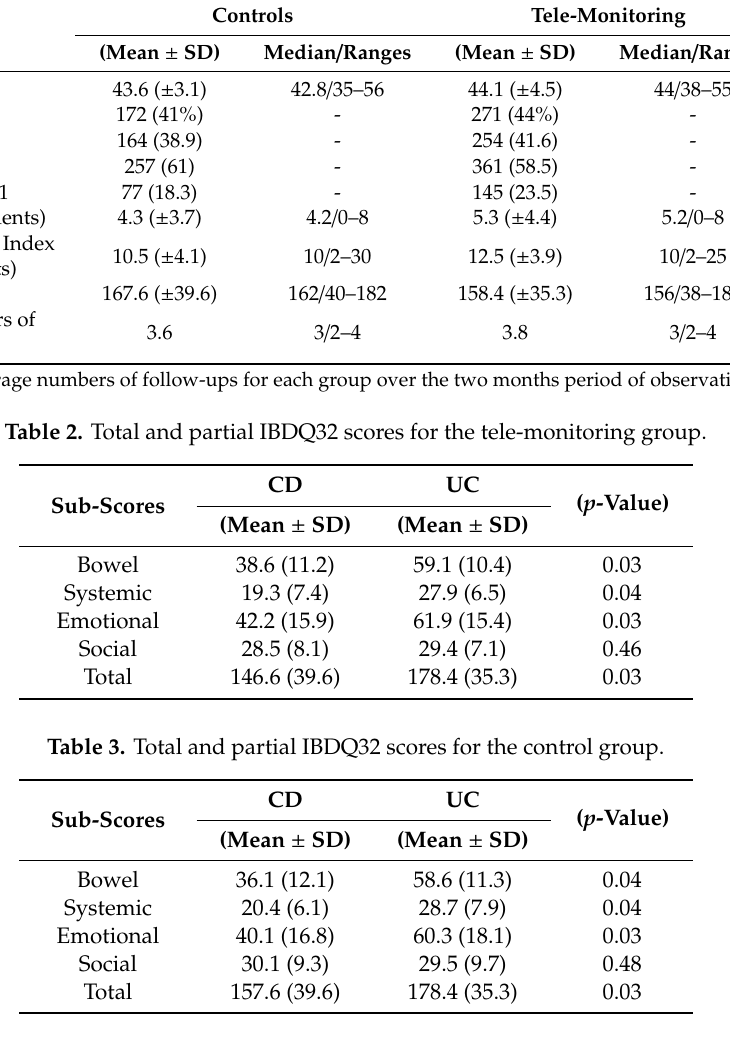
Table 4. Linear regression analysis of IBDQ32 as dependent variable, the tele-monitoring group (as principal regressor) compared to the control